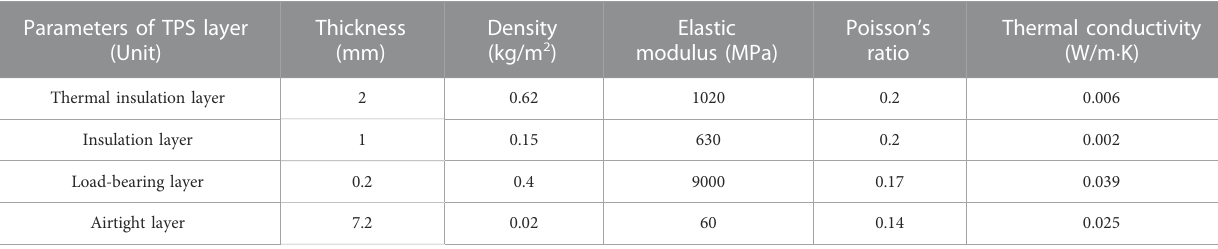
TABLE 1 Structural and material parameters of the in fl atable